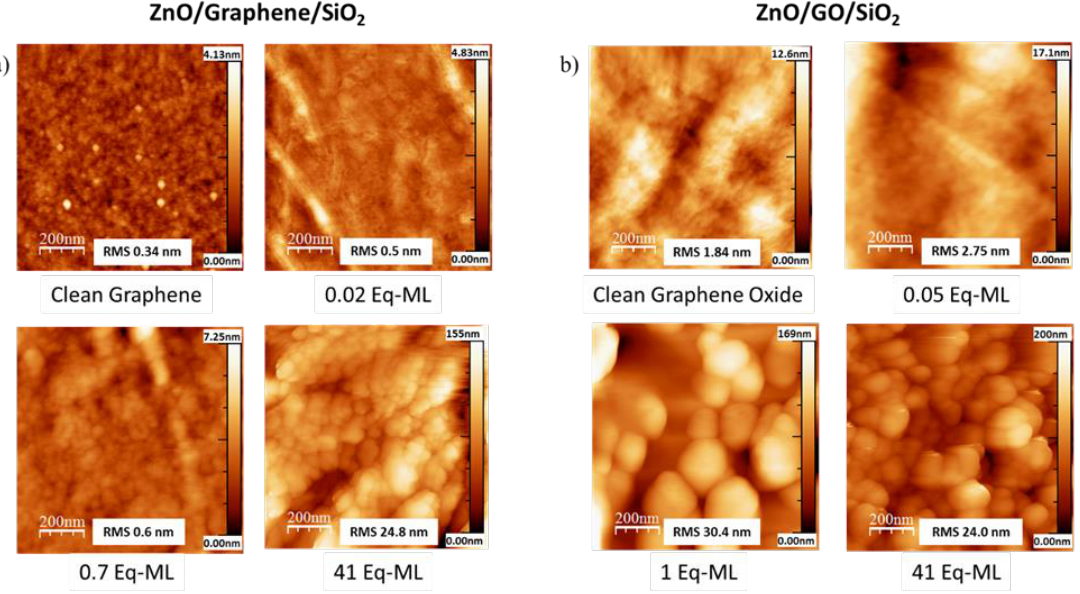
Figure 3. AFM images ( 1 × 1 μm 2 ) for different stages of growth of ZnO on ( a ) G/SiO2 and ( b ) GO/SiO 2 . The RMS roughness and the color scale bar for each image is given.